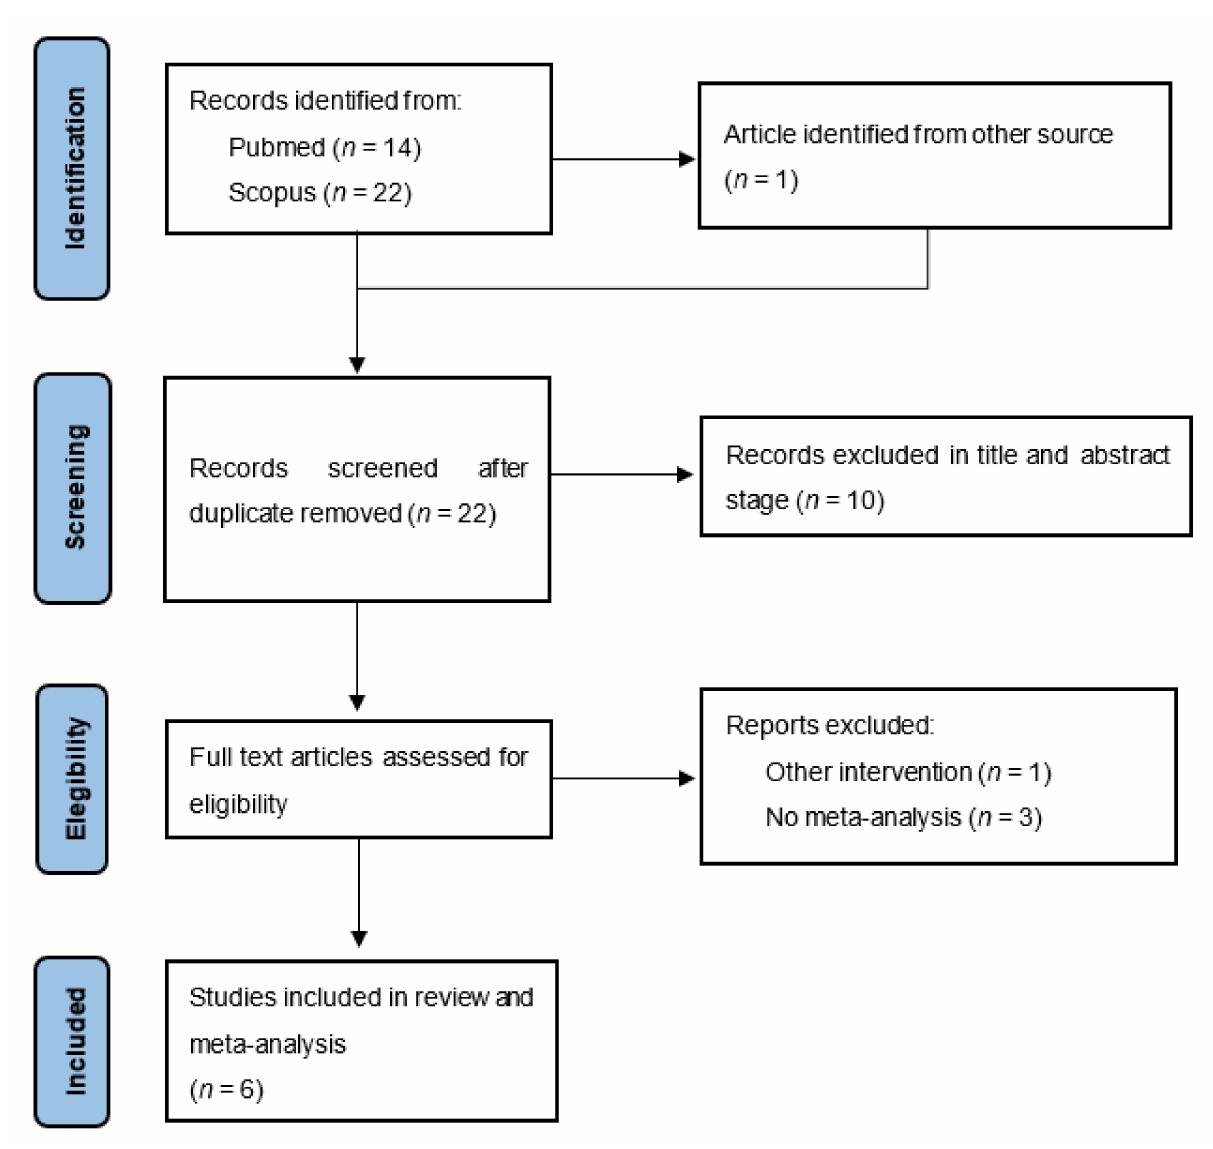
Figure 1. PRISMA flow diagram of study